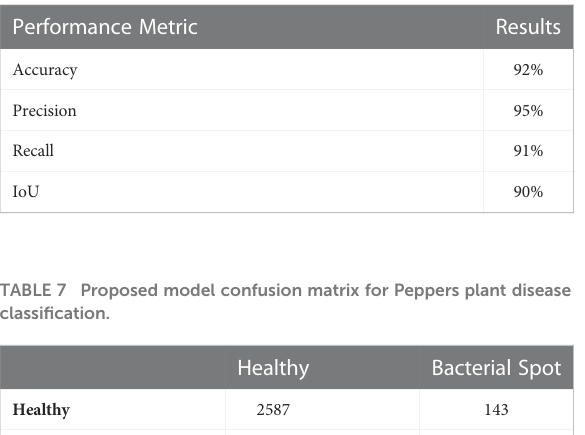
TABLE 6 Performance Analysis of the proposed leaf lesion segmentation model.